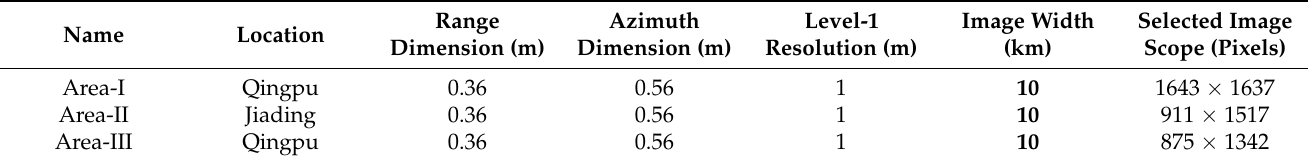
Figure 7. Area-I selected for testing the metho, and Area-II and Area-III selected for validating the method. The background color map is a GeoEye optical image provided by ArcMap, the three gray maps are China’s Gaofen-3 SAR images, and the line graph that includes four roads is labeled for analyzing the extraction results. Table 1. The Gaofen-3 SAR images (1 m resolution) for the three selected study